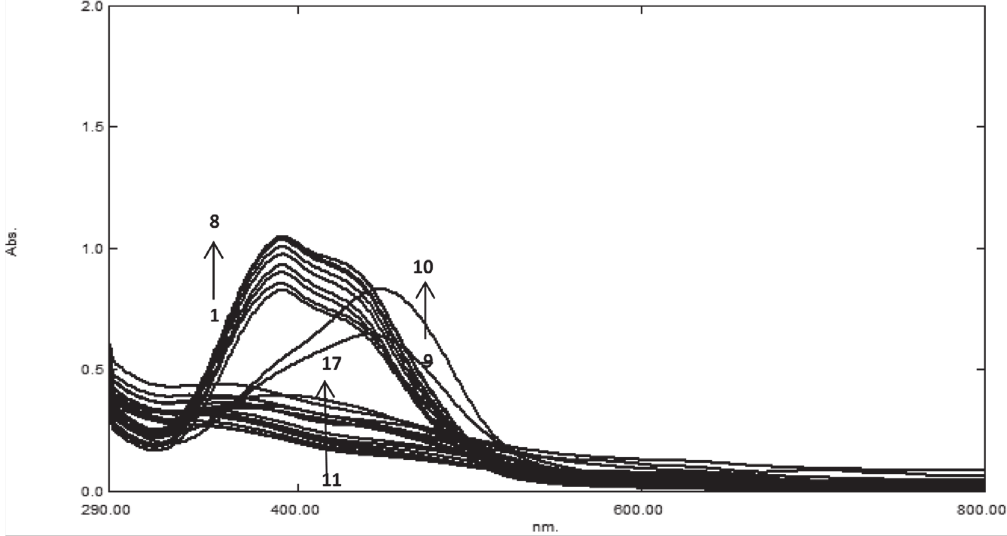
Figure 12: Effect of pH on 4-APAP; pH = (1) 2.2, (2) 3.5, (3) 4.7, (4) 5.5, (5) 6.4, (6) 7.35, (7) 7.56, (8) 7.87, (9) 8.22, (10) 8.86, (11) 9.2, (12) 9.4,